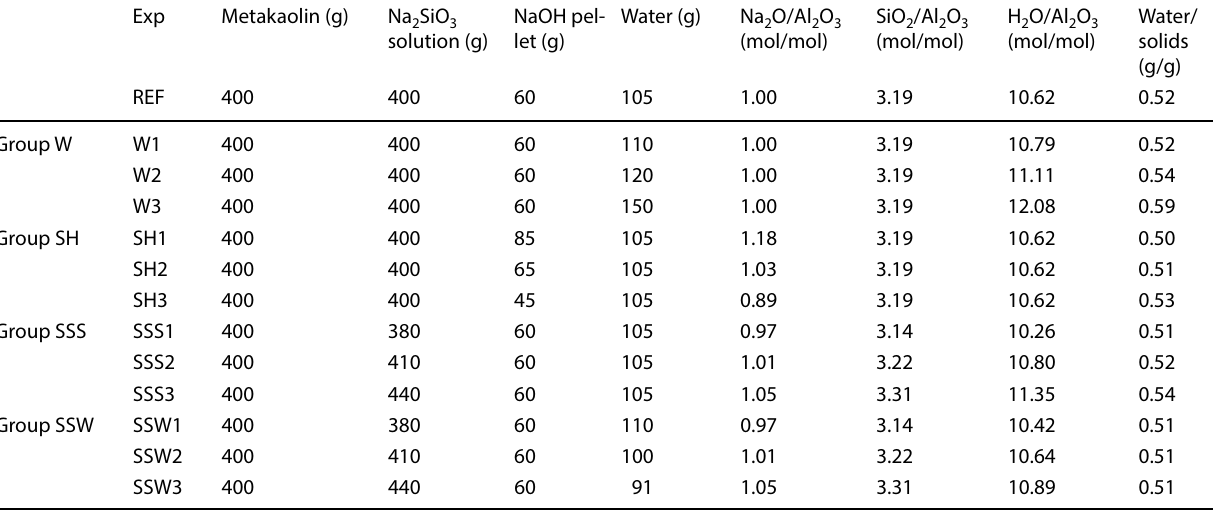
Table 2 Mix proportions and molar oxide ratios of metakaolin geopolymer